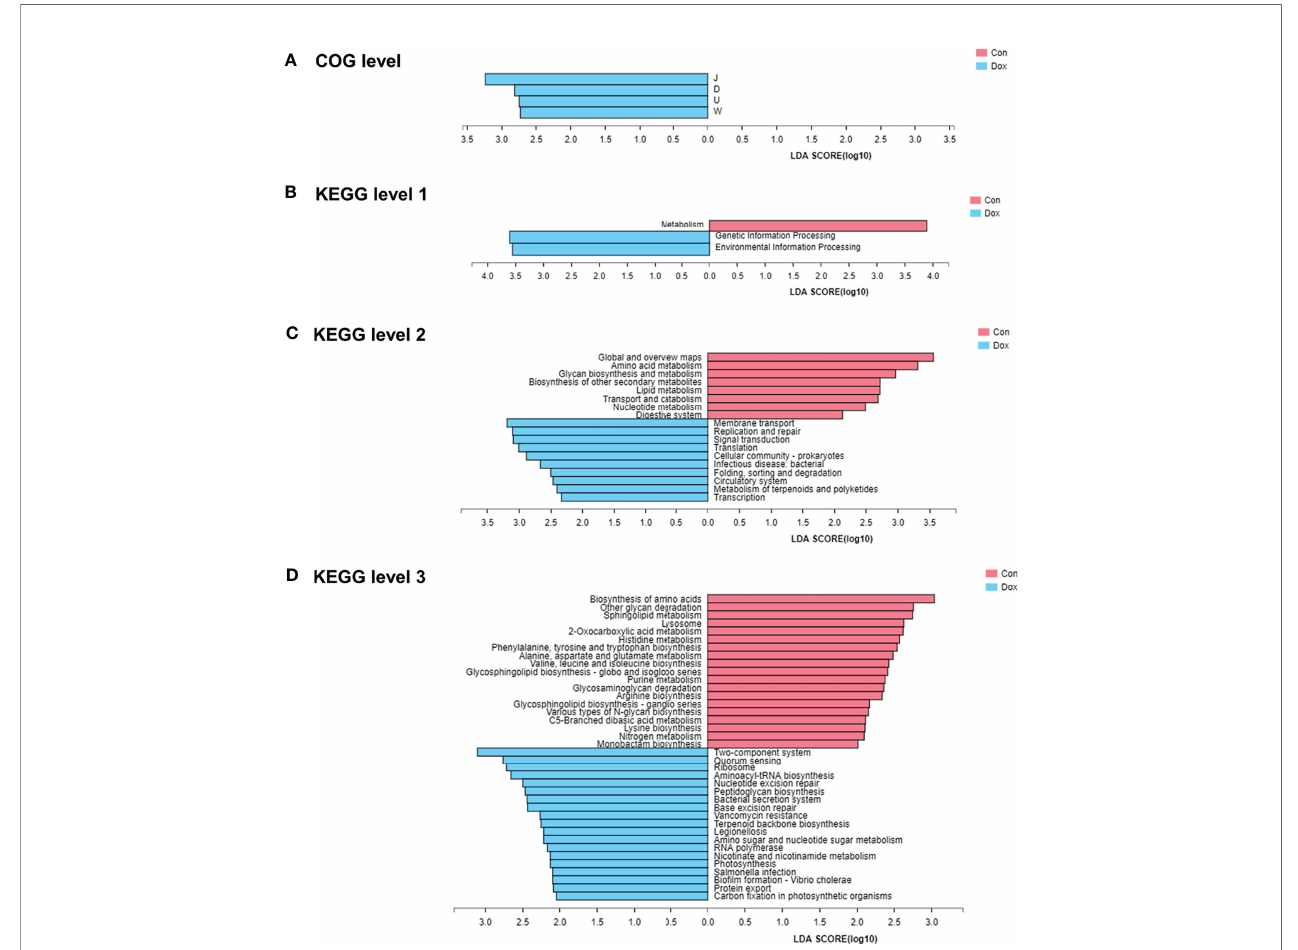
FIGURE 6 | The functional pathway comparisons in metagenome between Con and Dox groups were analyzed by LEfSe analysis (LDA > 2.0, p < 0.05). (A) Histogram of the LDA scores for the differences of COG functional categories. (B – D) Histograms of the LDA scores for the differences of KEGG functional pathways at three levels. Con, control; Dox, doxorubicin; LDA, linear discriminant analysis; LEfSe, linear discriminant analysis effect size; COG, Cluster of orthologous groups of proteins; KEGG, Kyoto Encyclopedia of Genes and Genomes. n =